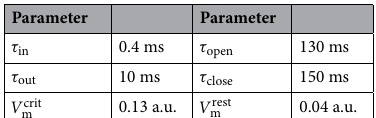
Table 4. This table lists the model parameters used for all simulations of the Mitchell–Schaeffer model.